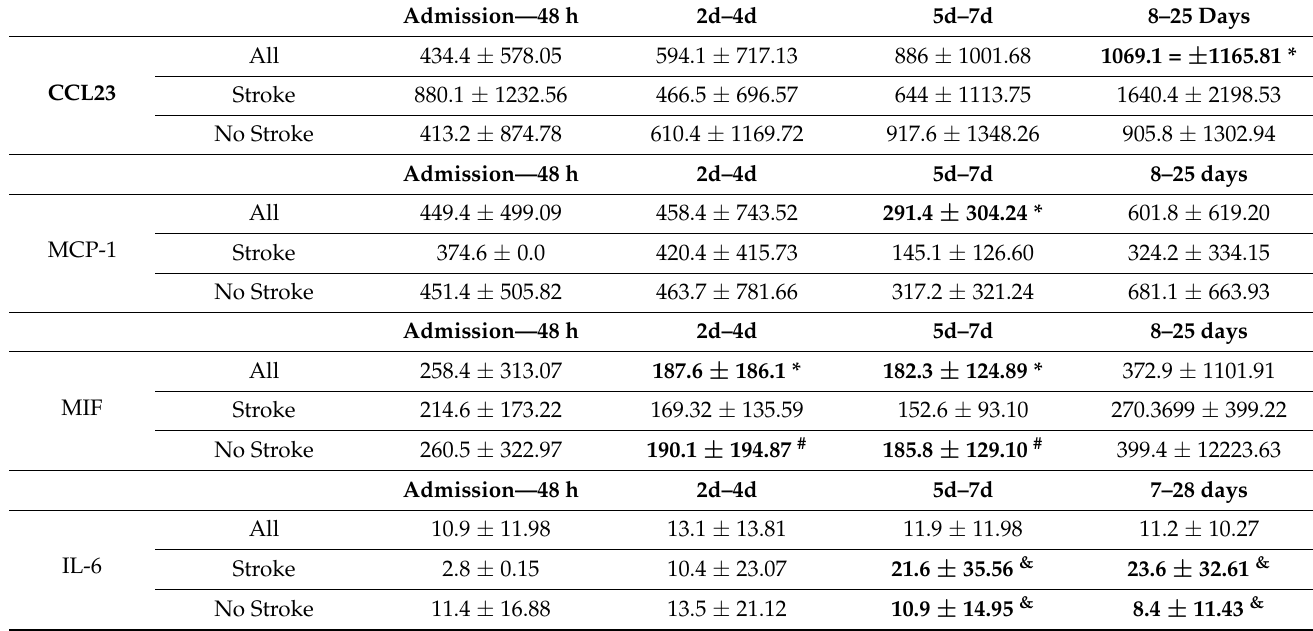
Table 2. Dynamics of inflammatory markers over time in all patients, and those who did vs. did not suffer from a stroke within 6 months following hospitalization for COVID-19.